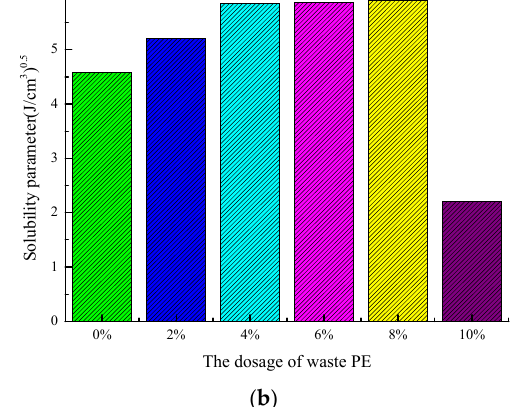
Figure 7. ( a ) Cohesive energy density and ( b ) solubility parameter of waste plastic/rubber-modified asphalt at various dosages of waste polyethylene.